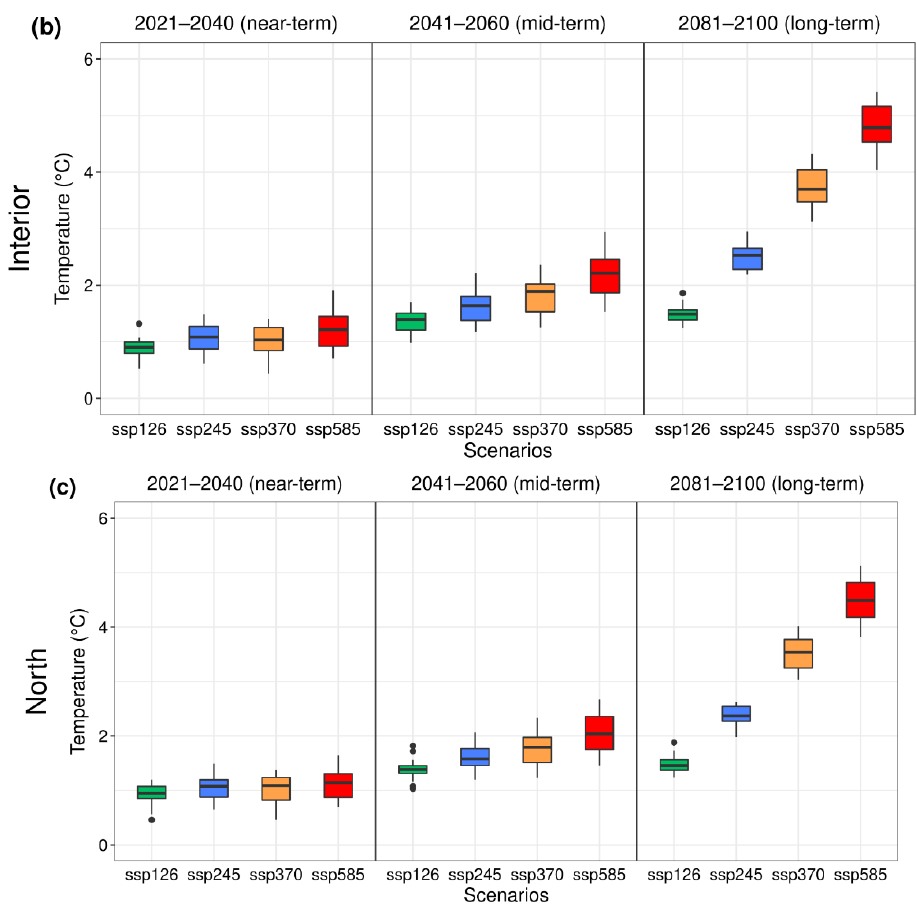
Figure 10. Boxplot of the air temperature anomaly CMIP6 for the near-term, mid-term, and long- term (end of the century) period: ( a ) East Coast, ( b ) Interior, and ( c ) North. The colored box plot corresponds to the average of the 15 models (ensemble) of CMIP6 for the SSP1-2.6, SSP2-4.5, SSP3-7.0, and SSP5-8.5 scenarios.